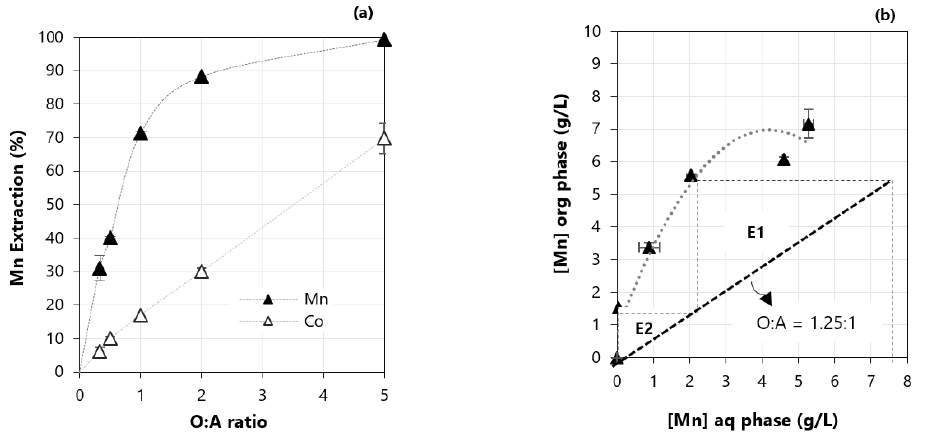
Figure 4. ( a ) Extraction of manganese and cobalt using different O:A ratios and ( b ) McCabe–Thiele diagram of the Mn extraction. Conditions: equilibrium pH of 3.5, 0.5 M D2EHPA, contact time of 10 min. Error bars represent the standard deviation of triplicates.